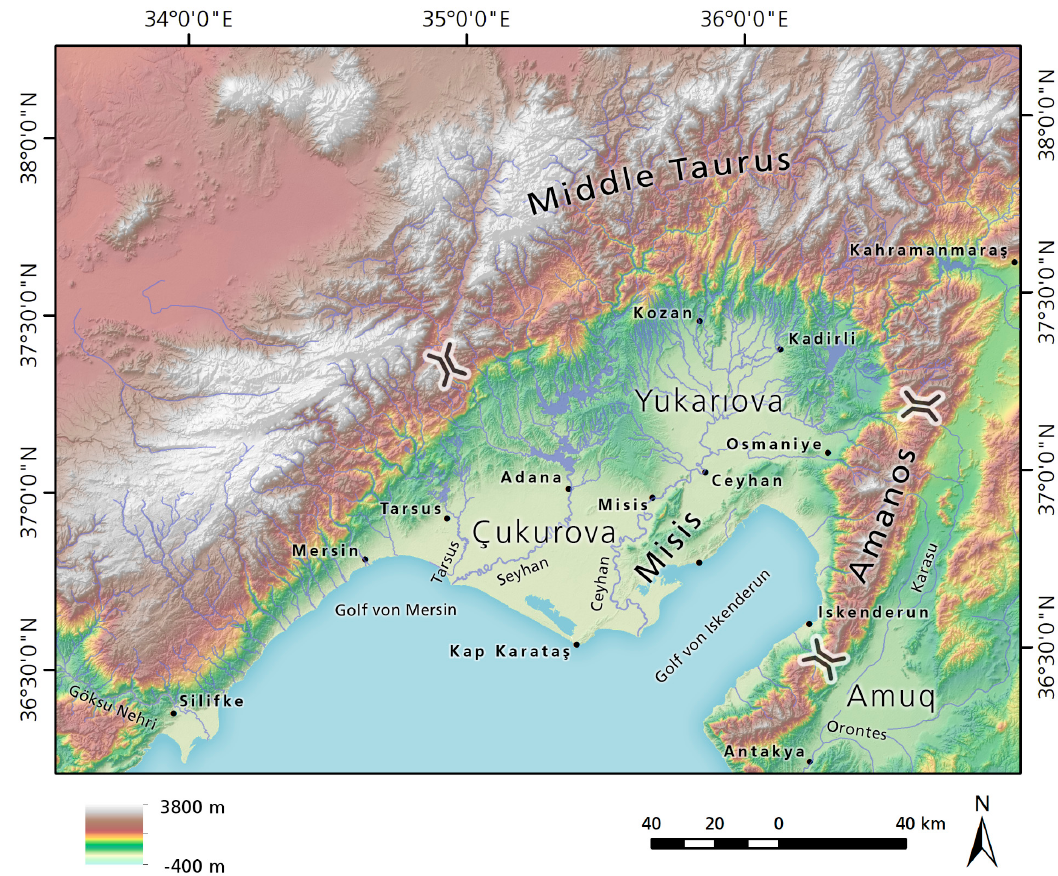
Figure 1. Map of Plain Cilicia and its neighboring regions. Topographic data based on SRTM (Shuttle Radar Topographic Mission, U.S. Geological Survey, 3 Arc Second scene) [9] © Susanne Rutishauser. Three main rivers, originating in the Taurus Mountains, cross the lowlands and discharge into the Mediterranean Sea: Berdan or Tarsus Çay ı (gr. Kydnos ), Seyhan (hitt. Šamri / Sapara , gr. Saros ) and Ceyhan (hitt. Puruna , gr. Pyramos ) [10] (p. 6). These rivers form the deltaic complex that occupies the